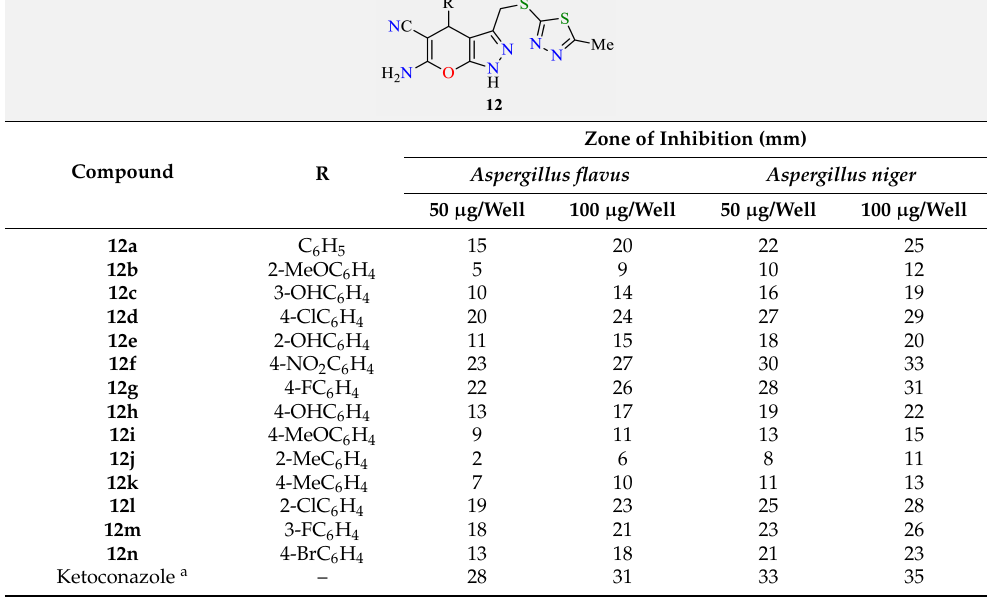
Table 39. Antifungal activity of pyrano[2,3- c ]pyrazole derivatives 12